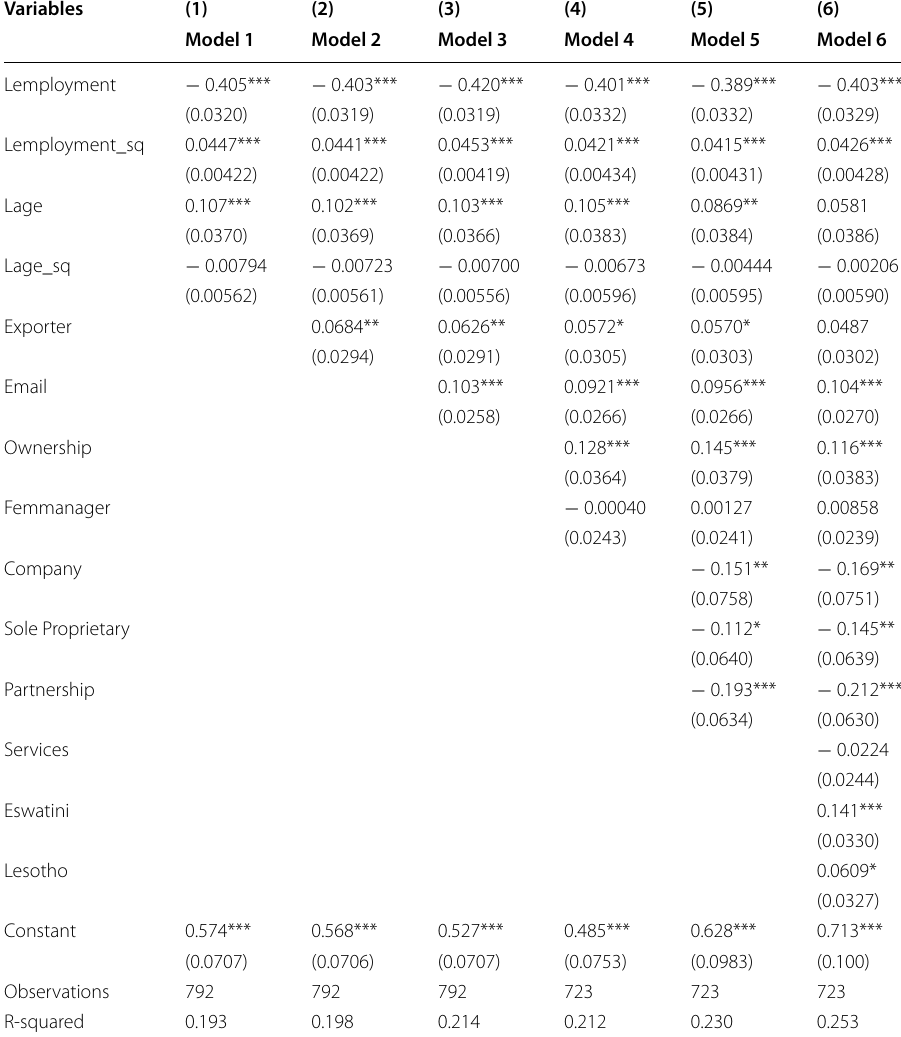
Table 2 Main results-determinants of employment